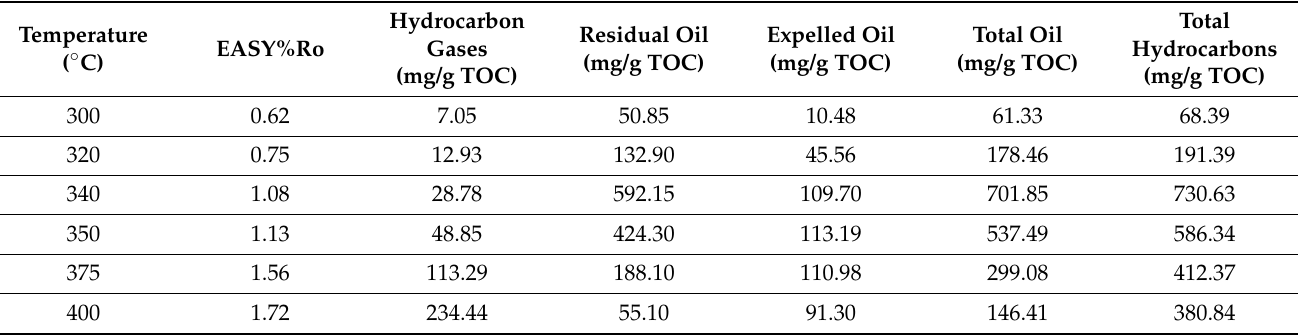
Table 2. Yields of hydrocarbons of oil shale sample Aus-2 during the artificial thermal simulation experiments over the temperature range from 300 ◦ C to 400 ◦